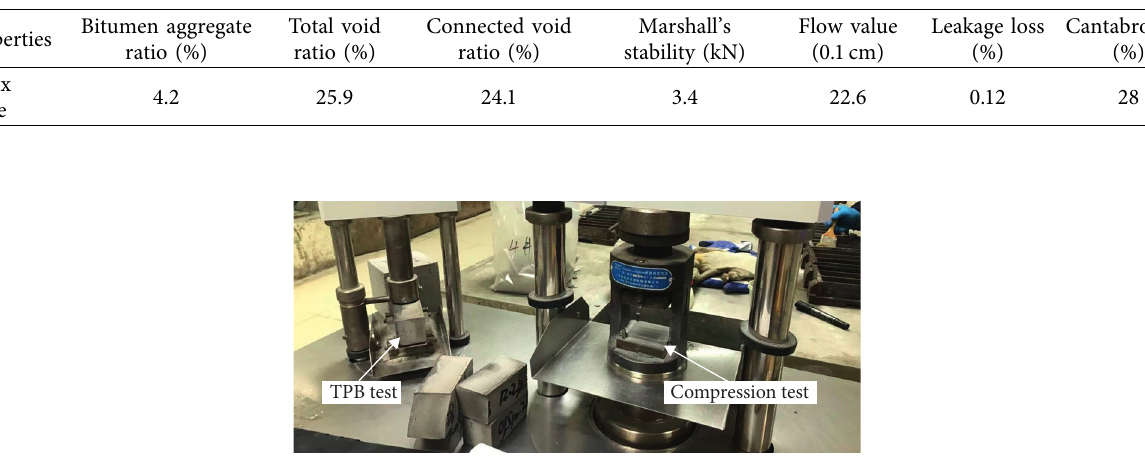
Table 4: Properties of PA mixture.